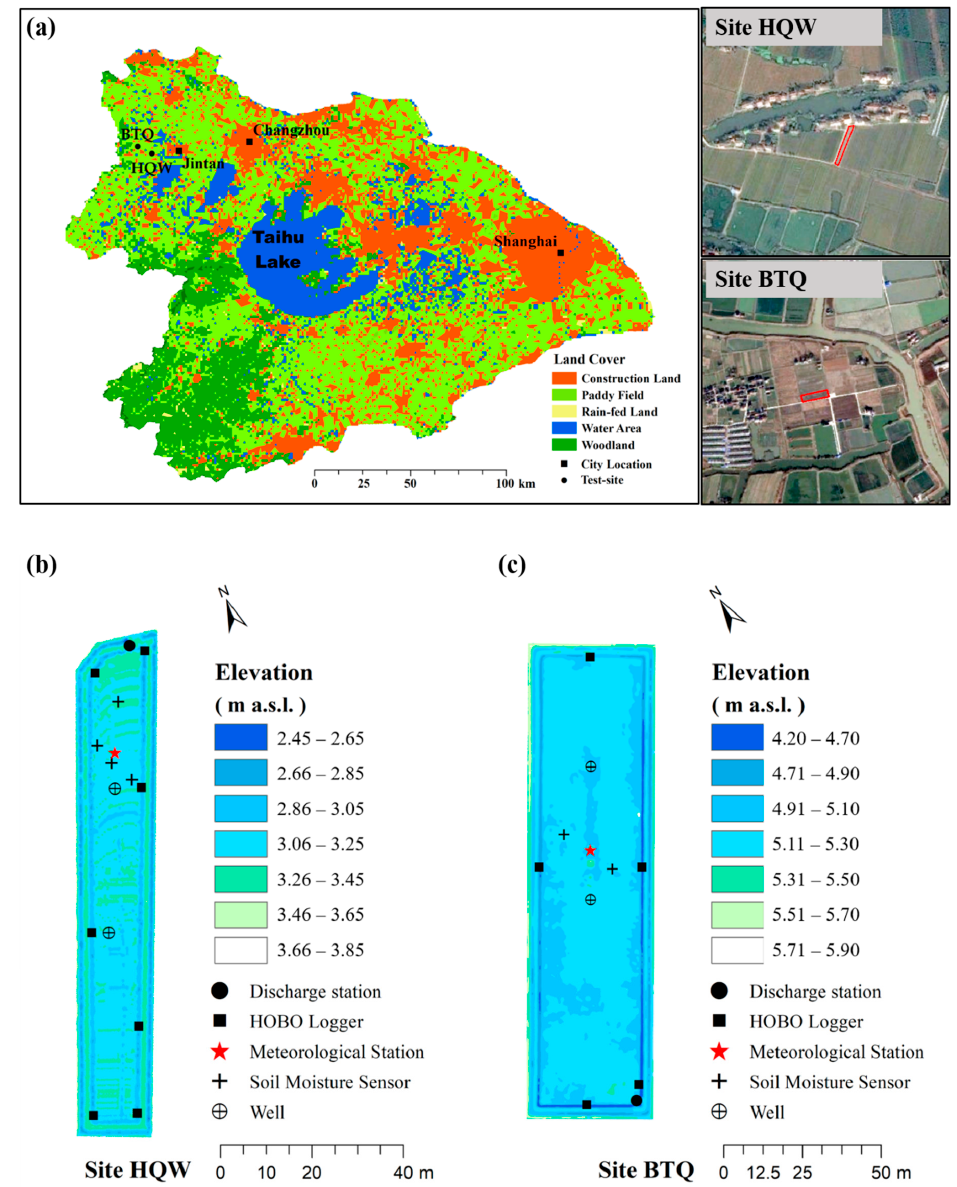
Figure 1. Test site layout: ( a ) sites of the study in the Taihu Basin; ( b ) surface elevation and instrumentation in the Hongqiwei (HQW) site; ( c ) surface elevation and instrumentation in the Baitaqiao (BTQ) site.